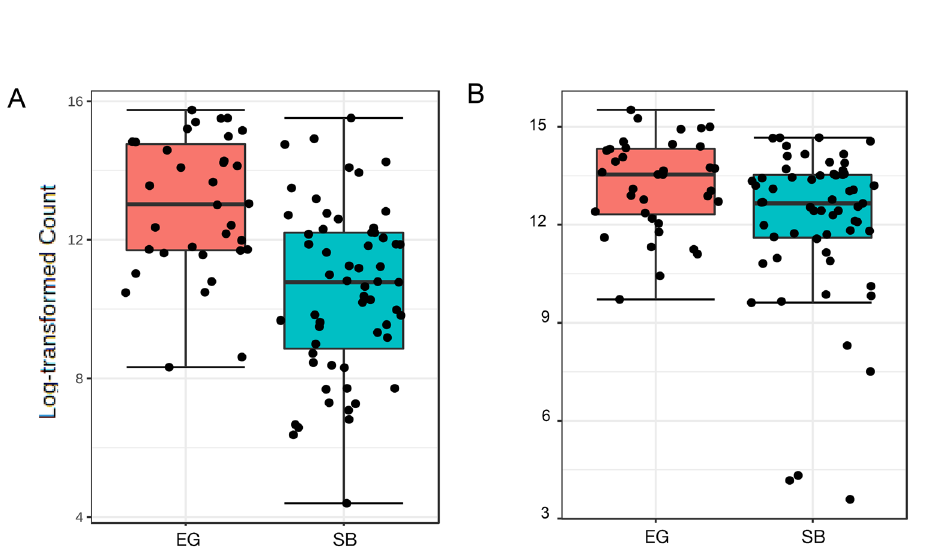
Figure 3. Boxplots of log-transformed counts for bacterial classes showing differential abundances of ( A ) Bacilli, significantly higher in East Greenland (EG) than Southern Beaufort Sea (SB) polar bears (Group means: EG: 13.0 ± 0.3; SB: 10.5 ± 0.3) ( B ) Coriobacteria, significantly higher in EG than in SB polar bears (Group means: EG: 13.1 ± 0.2; SB: 12.0 ± 0.3). Analysis of composition with bias correction (ANCOM-BC) test results summarized in Supplementary Table